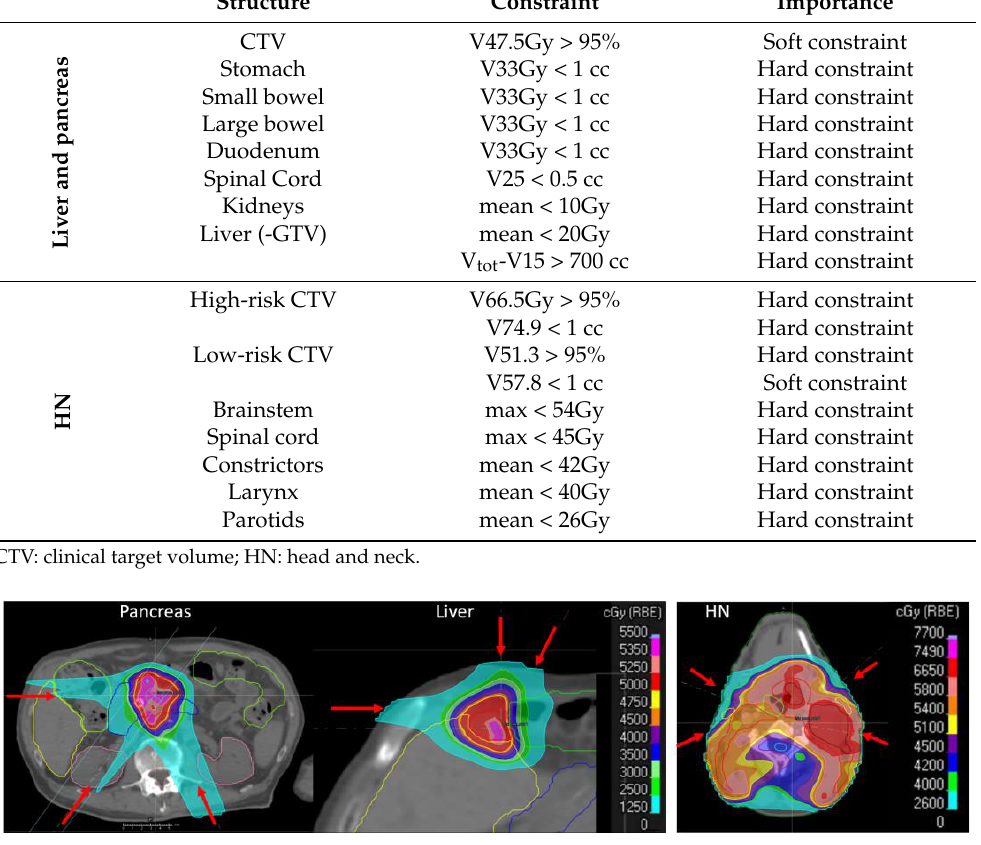
Figure 1. Example treatment plans for pancreas, liver, and HN patients. The red arrows depict the beam directions.